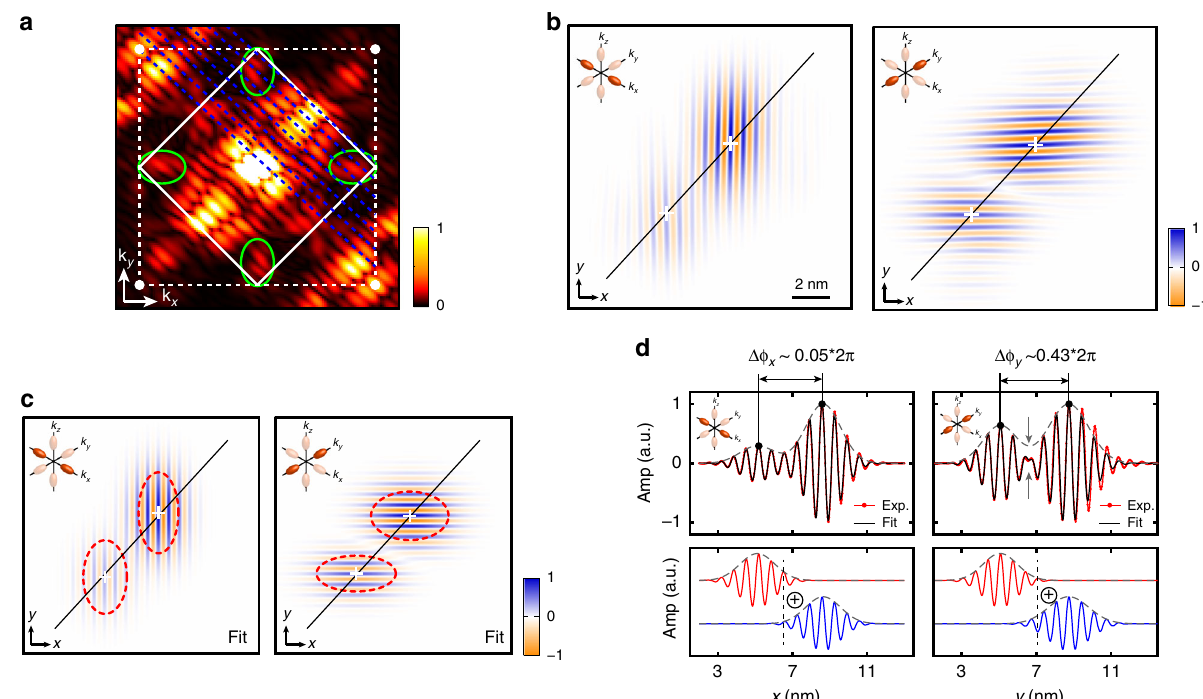
Fig. 2 Visualising and quantifying valley interference between coupled donors. Pair #1. a 2D FFT of the STM image, centred on the fi rst Brillouin zone (solid white lines). The white dots are located at {± k 0 , ± k 0 }. The FFT shows a clear valley signal around k μ ~ 0.81 k 0 evidenced by the green ellipsoids. The FFT also shows diagonal slices (blue dotted lines), cutting through the valley components of the FFT, which evidence the geometric interference between the two donors. b Real-space images of the valley interference, obtained after inverse Fourier transform of the FFT fi ltered around k x ~ 0.81 k 0 for the x - valley interference (left) or k y ~ 0.81 k 0 for the y -valley interference (right). The white crosses indicate the donor positions. The x -valleys look in-phase with the vertical stripes running continuously from one donor to the other. The y -valleys look out-of-phase with a clear discontinuity in the oscillatory valley pattern between the two donors. c 2D fi ts of the valley images, from which the position of the valley maxima and of the valley frequency, and hence the valley phase differences Δ ϕ x and Δ ϕ y , can be obtained. The red dashed ellipsoids correspond to the donor envelope part of the fi ts, which highlights their anisotropy. d Line cuts taken through the ion – ion direction of both valley images (red lines) and their fi t (black lines), for the x -valleys (left) and the y - valleys (right). The grey dashed lines represent the envelope part of the fi ts only. The x -valleys are in-phase, which results in the maxima of valley signal to always reach the envelop part. On the contrary, the y -valleys are out-of-phase and the grey arrows in-between the two donors highlight the clear reduction of the valley signal compared to the envelope part as a result of the destructive